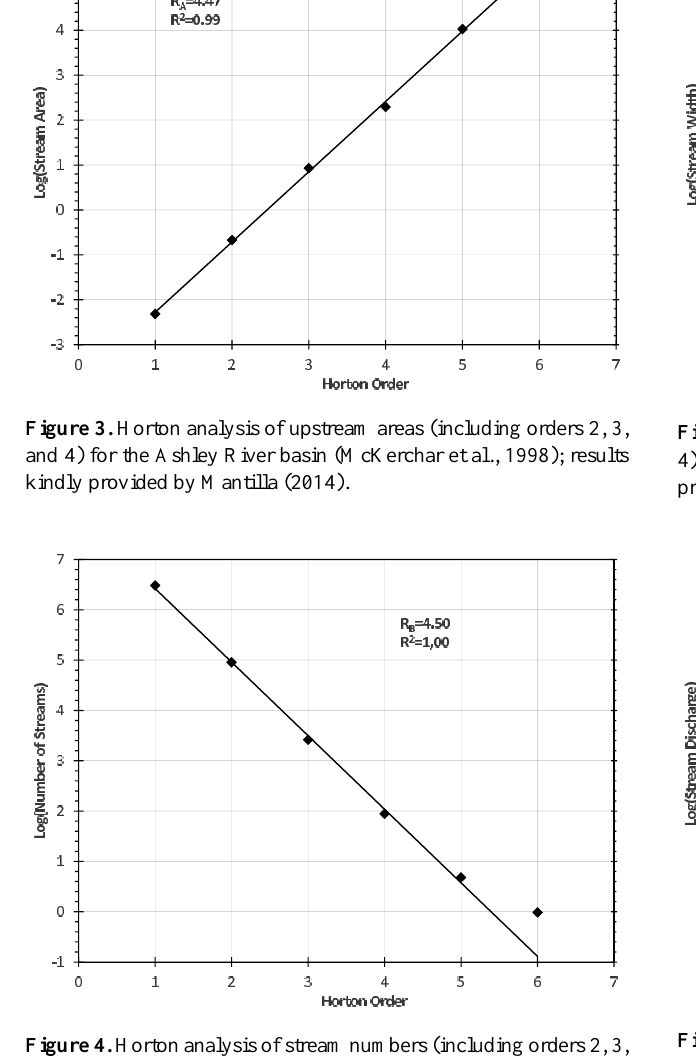
Figure 4. Horton analysis of stream numbers (including orders 2, 3, and 4) for the Ashley River basin (McKerchar et al., 1998); results kindly provided by Mantilla (2014).